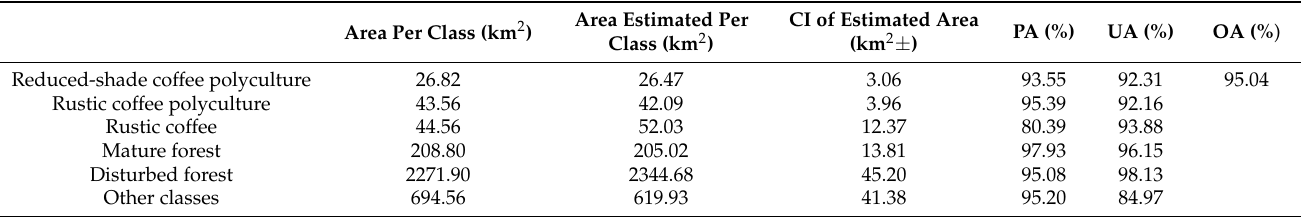
Table 6. Accuracy statistics, where CI = confidence interval, PA = producer accuracy, UA = user accuracy, OA = Overall accuracy, ± =